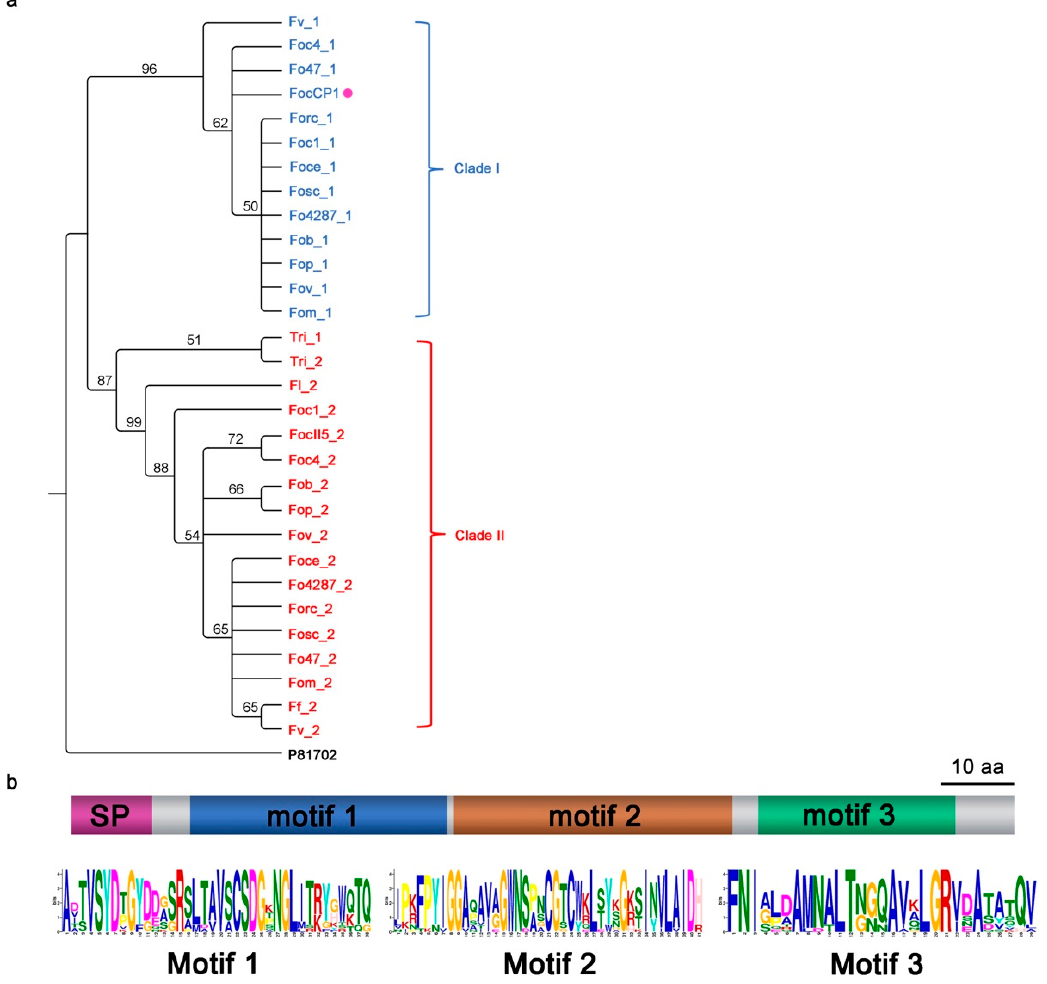
Figure 1. Analysis of the cerato-platanin (CP) protein FocCP1. ( a ) Maximum likelihood tree based on CP (P81702) and its 32 orthologous proteins from Fusarium spp. and Trichoderma atroviride genomes. The number of branches was the bootstrap support percentages of each branch and branches with < 50% support rate were condensed. ( b ) Conserved motifs of CP proteins predicted with the MEME suite. All analyzed CP proteins exhibited three motifs.